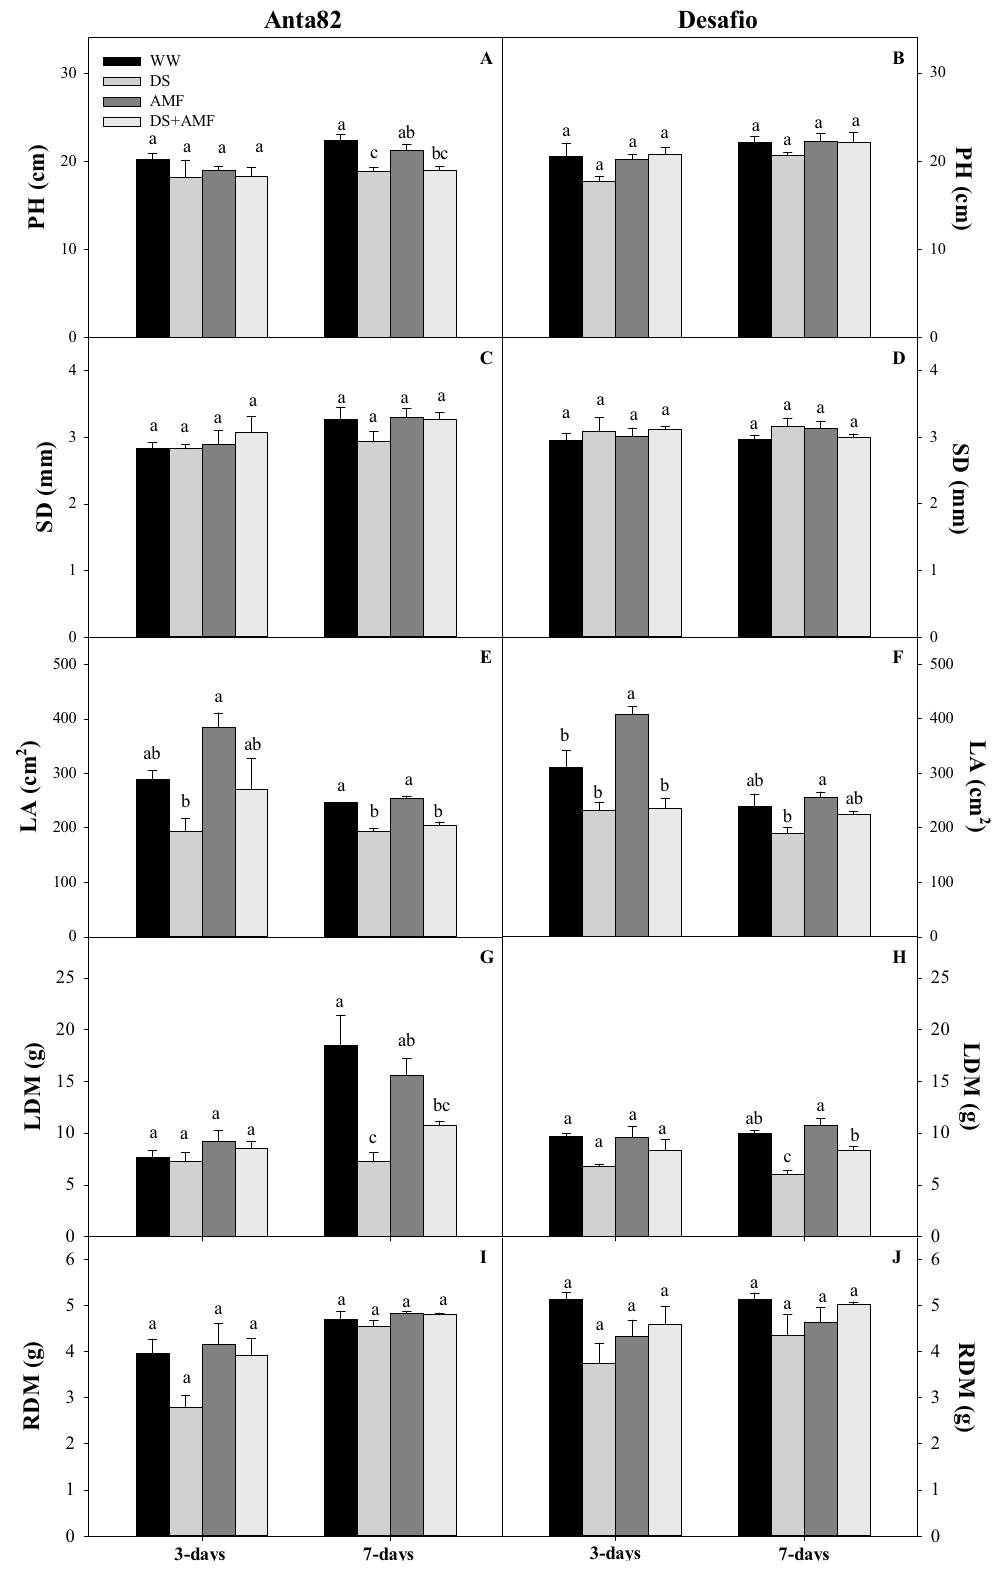
Figure 7. Plant height (PH), stem diameter (SD), leaf area (LA), leaf dry matter (LDM) and root dry matter (RDM) on days 3 and 7 in the ( A , C , E , G , I ) Anta82 and ( B , D , F , H , J ) Desafio soybean cultivars under different conditions of inoculation and water stress. WW = well-watered, noninoculated, DS = drought stress, noninoculated, WW + AMF = well-watered and inoculated, DS + AMF = drought stress and inoculated. The bars represent the mean ± SEM ( n = 4). Pairs of means in the same period (3 or 7 days) with different letters are significantly different ( p < 0.05) based on Tukey’s post hoc